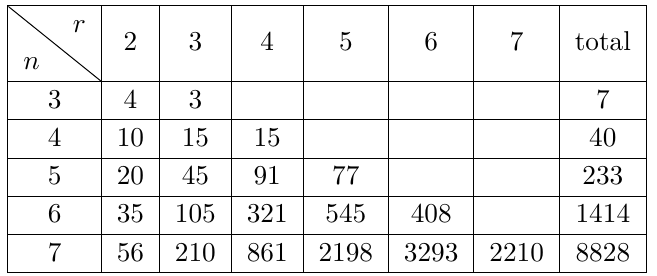
Table 1. The number of r + 1 scalar YMS amplitudes appear in the decomposition of 2 ) (1 , 2 , . . . , n ) F tr( F n